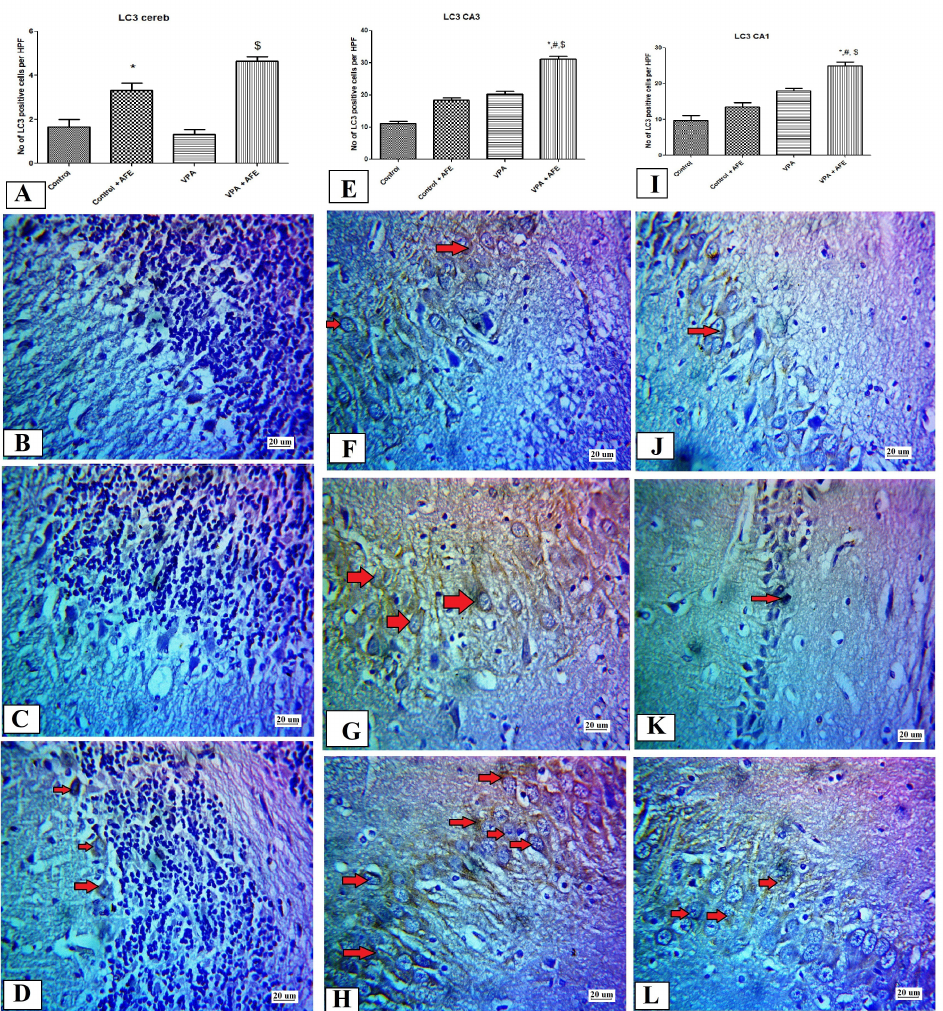
Figure 7. Effect of AFE on the LC3 expression in the cerebellum and hippocampus. ( A , E , I ) show the mean number of LC3-positive cells in the Purkinje cells (PC) layer of the cerebellar cortex, CA3 hippocampal region, and CA1 hippocampal region of different groups, respectively. ( B ) shows negative cytoplasmic expression of LC3 in the PC of the cerebellar cortex of the control, minimal LC3 expression in the VPA group ( C ), and moderate expression in the VPA + AFE group ( D ). ( F – H ) show positive cytoplasmic expression (red arrows) of LC3 in CA3 of the control group (mild to moderate), VPA group (mild-moderate), and VPA + AFE groups (marked), respectively. ( J , K ) show minimal cytoplasmic expression of LC3 in CA1 of the control group and VPA group, and ( L ) moderate cytoplasmic expression in the VPA + AFE groups, respectively (400 × ). * significant vs. control group, # significant vs. control + AFE group, and $ significant vs. VPA